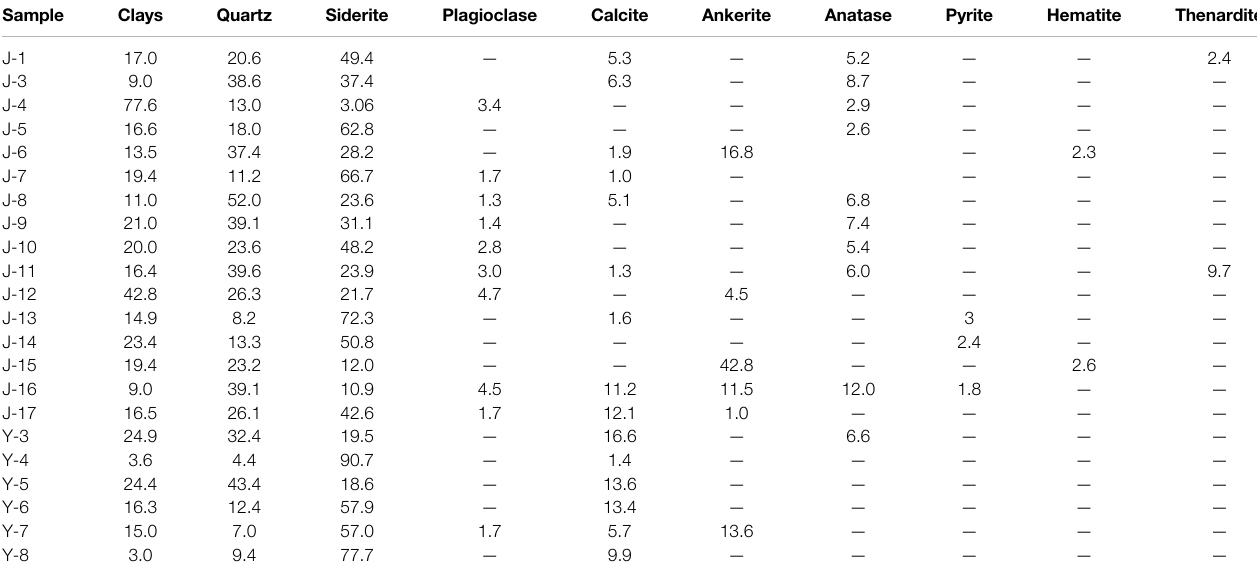
TABLE 1 | Mineral compositions of the studied samples determined by XRD analysis (wt%). Sample Clays